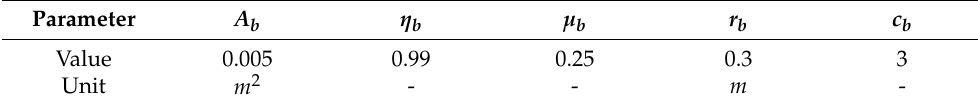
Table 4. Brake related parameter